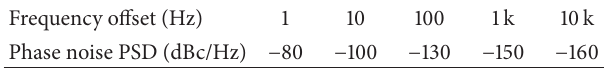
Figure 3: Prediction of phase noise in a typical 10MHz crystal oscillator. Table 1: Phase noise parameters of one typical crystal